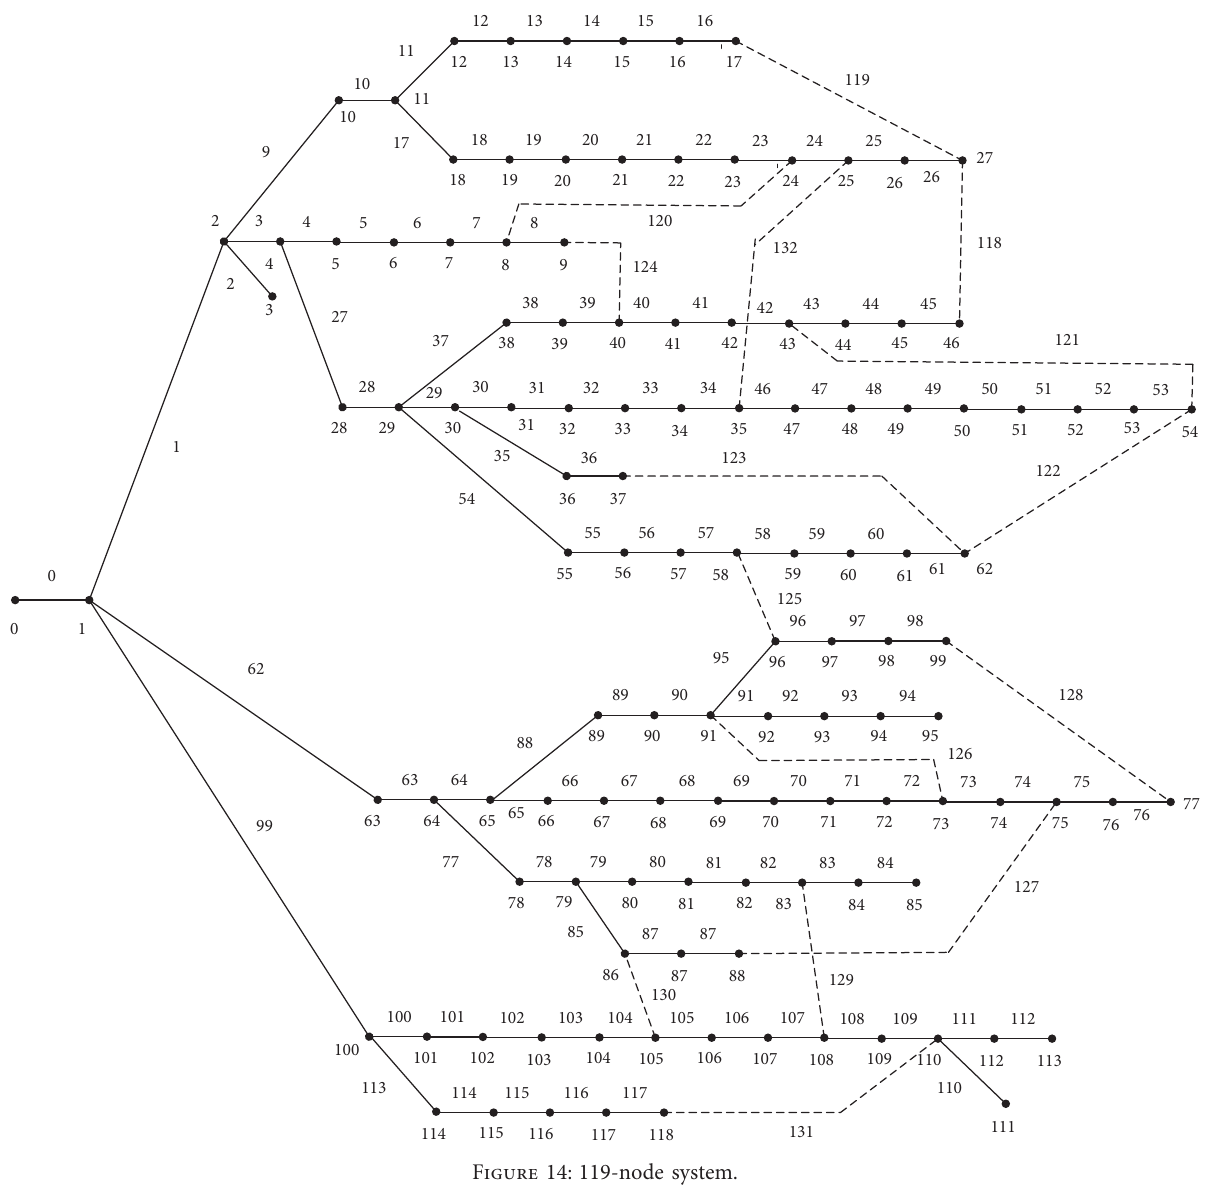
Figure 14: 119-node system.